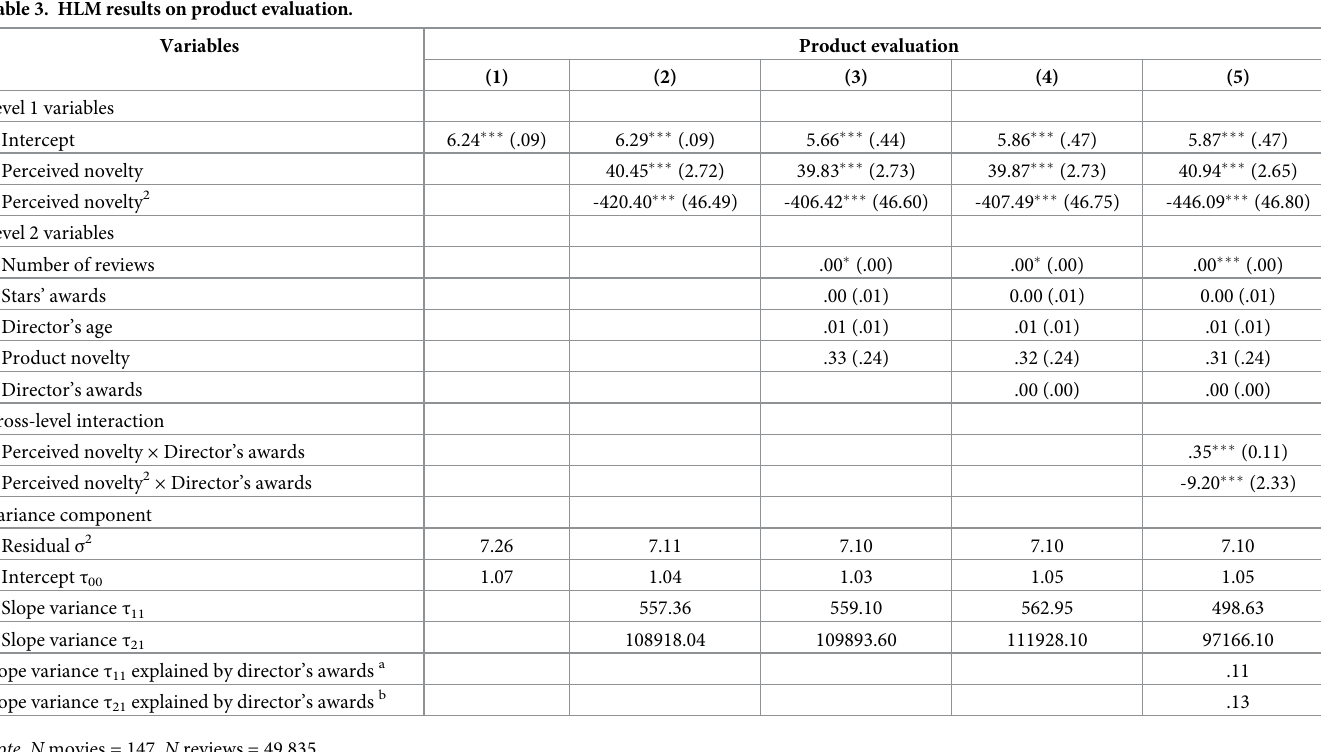
Table 3. HLM results on product